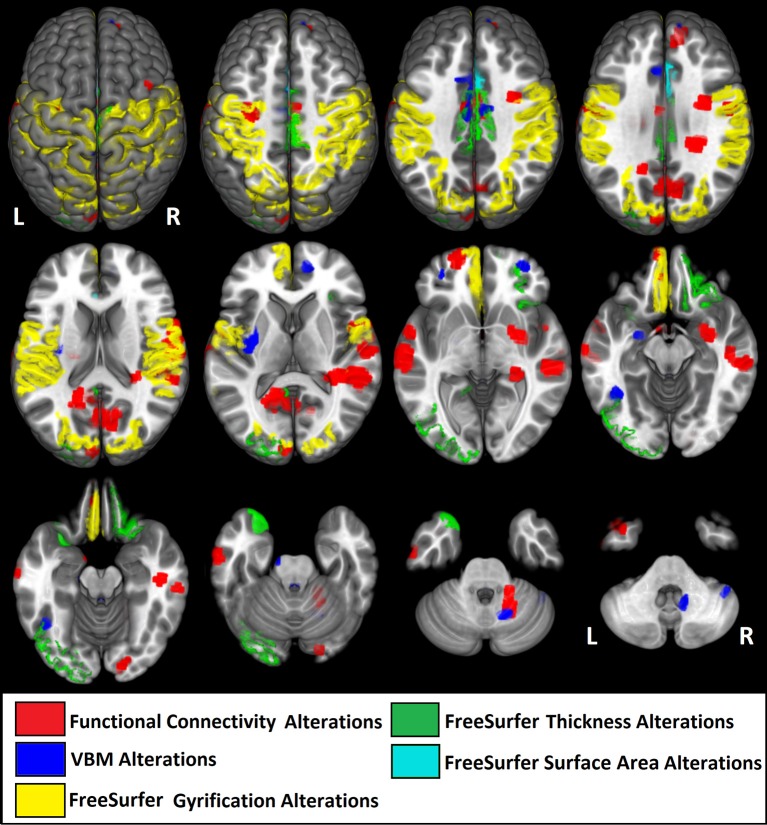
Illustrative figure showing anatomical localization of abnormalities in functional connectivity (in red), voxel-based morphometry (VBM, in blue), and FreeSurfer ROI analysis of gyrification index (in yellow), cortical thickness (in green), and surface area (in light blue). The areas indicated in this figure do not correspond to the maximum voxel statistical location, but rather the sub anatomical regions with significant differences in patients with high functioning autism compared to controls. See Tables 2–7 for the centroid MNI coordinates of maximal abnormalities and Table 8 for a summary of the location of increased and decreased changes as compared to controls.